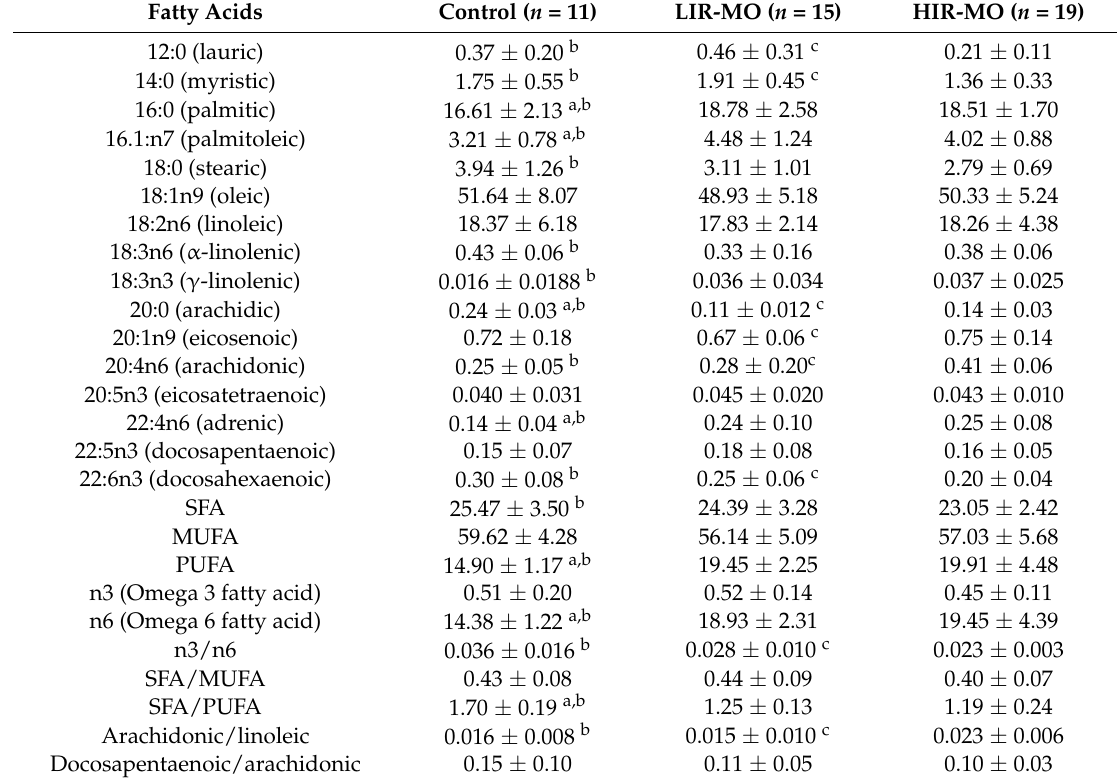
Table 2. Fatty acid composition in the visceral adipose tissue of normal-weight and obese